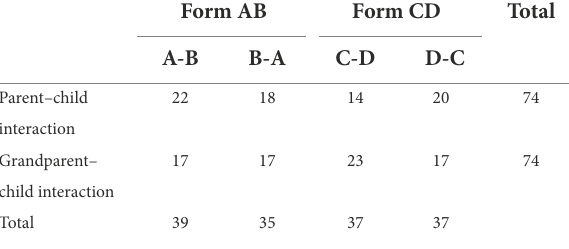
TABLE 2 Distribution of experimental